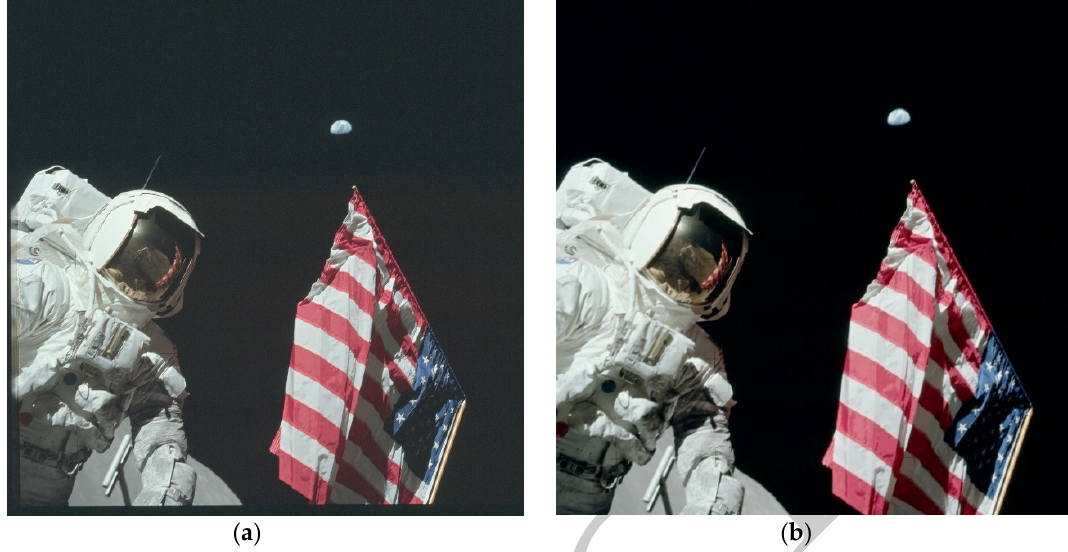
Figure 1. ( a ) According to NASA, the photo shows astronaut-geologist Harrison Schmitt, pilot of the Apollo 17 lunar module, who was photographed near the American flag while reaching the lunar surface. The picture was taken on 13 December 1972 in the Taurus Littrow region. The upper end of the flag points to our planet Earth in the background; ( b ) same photo with increased gamma correction.